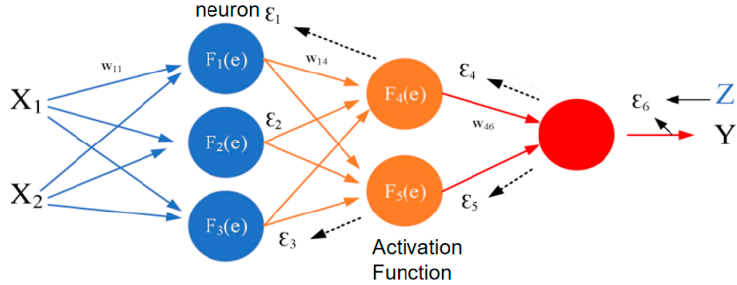
Figure 11. B ack p ropagation neural network construction reference. Figure 11. Back propagation neural network construction